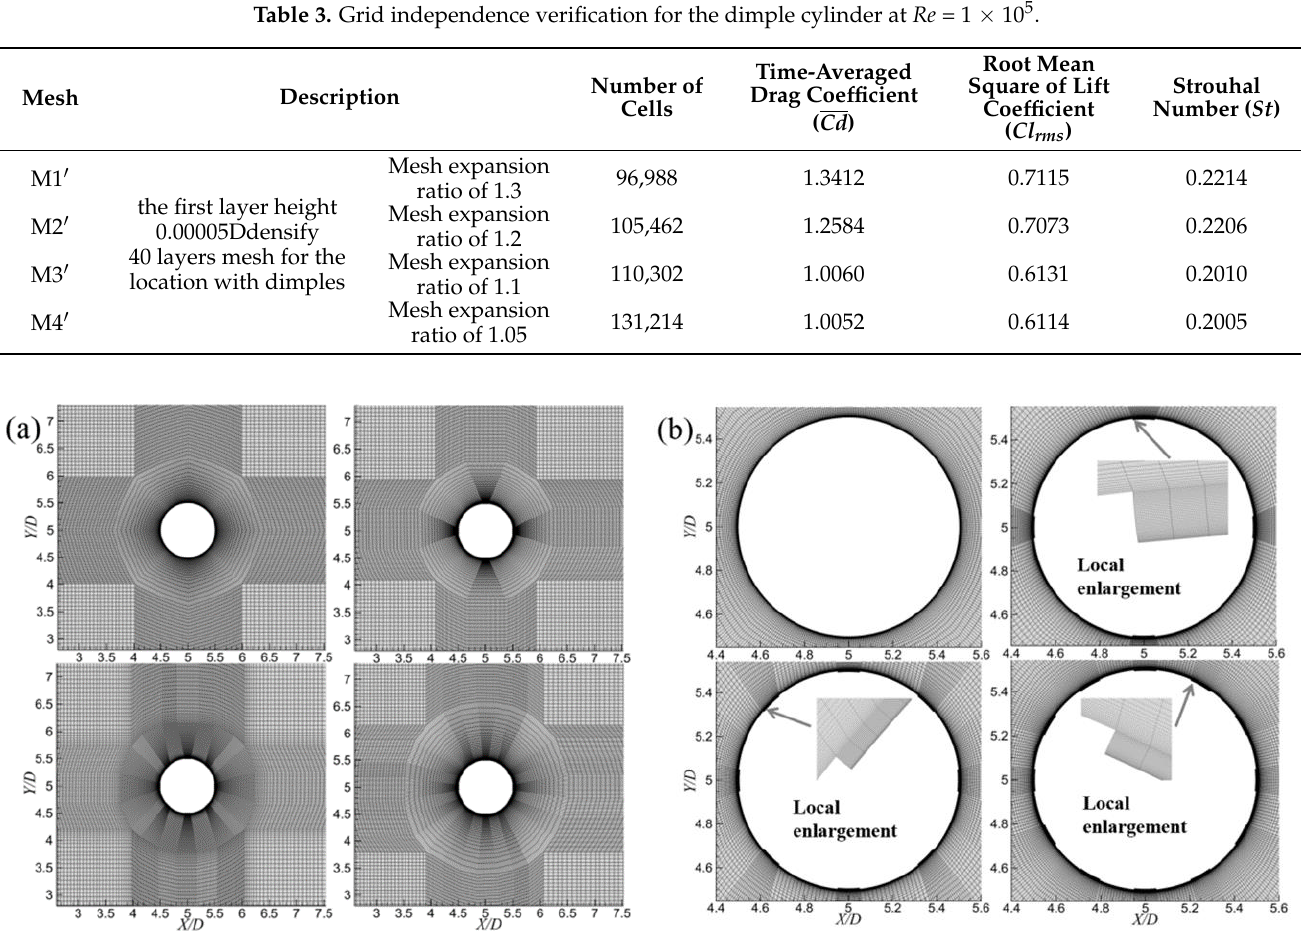
Table 3. Grid independence verification for the dimple cylinder at Re = 1 × 10 5 .